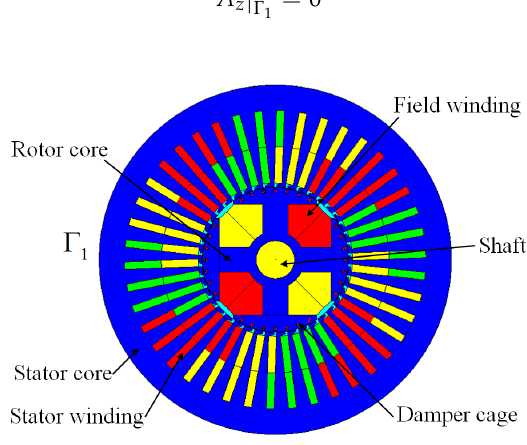
Figure 4. 2-D FE model cross section of prototype.